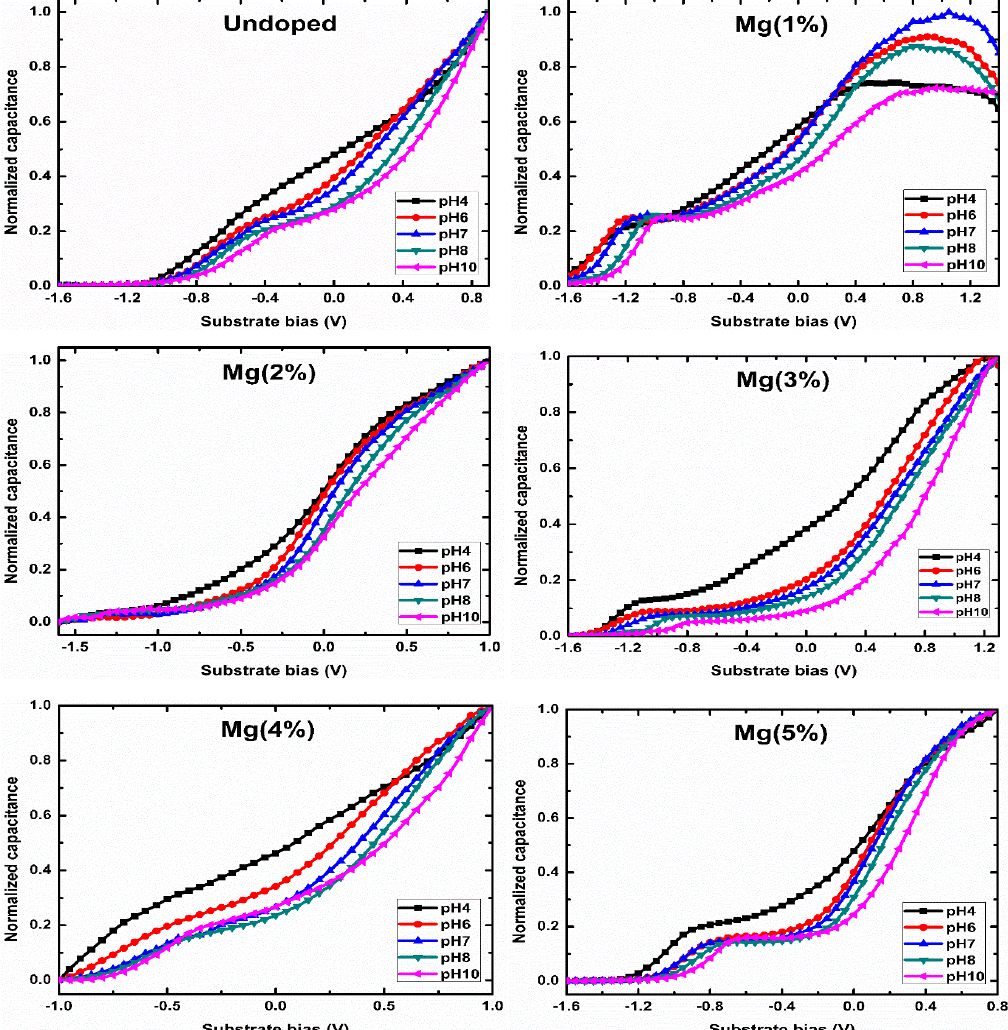
Figure 7. The normalized C–V curves of the ZnO nanorod samples undoped and doped with different Mg contents. The ZnO nanorods maximum threshold voltages shifted after the Mg doping reached 3%, showing that the devices’ sensitivity reached the highest value of 83.77 mV/pH with a 96.06% linearity. The undoped ZnO nanorod sensing membranes’ sensitivity was 67.24 mV/pH with a 97.06% linearity. The fabricated samples’ sensitivity after Mg doping was 68.71, 37.74, 83.77, 72.55, and 38.75 mV/pH at Mg contents ranging from 0 to 5%, respec- tively, as presented in Figure 8. The normalized C–V curves shift as the pH values in- crease, which is attributed to changes in oxide films’ capacity caused by changes in the number of binding sites available for H + and OH − on sensing membranes [33]. The incor- poration of impurities improves the surface and interfacial material quality and increases the surface site density. Since Mg has a higher affinity to O, a doping process promotes the morphological changes and increases the crystal grain formation, supporting the in- crease in the surface roughness with the number of surface defects and improving the detection performance (the sensitivity and linearity) of devices [53,54].